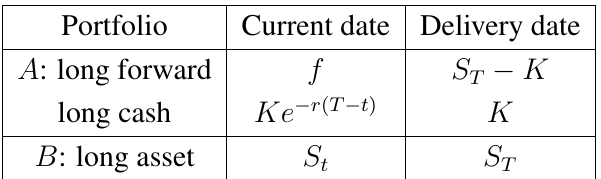
Table 8. Values of alternative